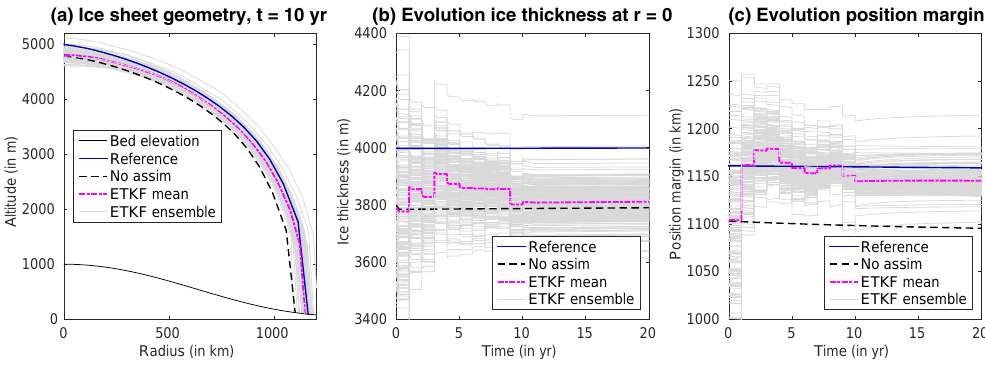
Figure 16. ETKF results for the advanced configuration where observations of surface ice velocity and the position of the margin are assimilated over the first 10 years and a forecast is made for the following 10 years. (a) ETKF analysis at time t = 10 years compared with the reference. (b) Evolution of the ice thickness at r = 0 with time. (c) Evolution of the position of the margin with